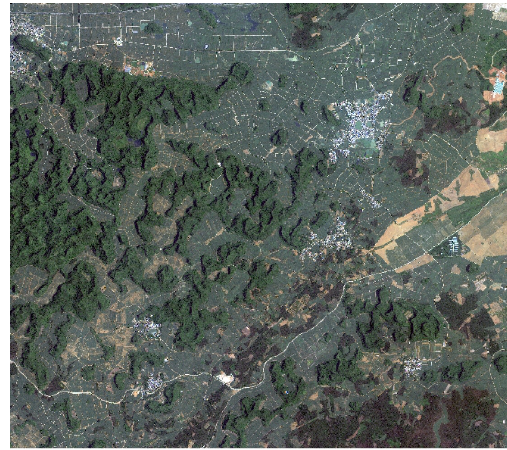
Figure 4 BJ-2 Image Data of the Experimental Site